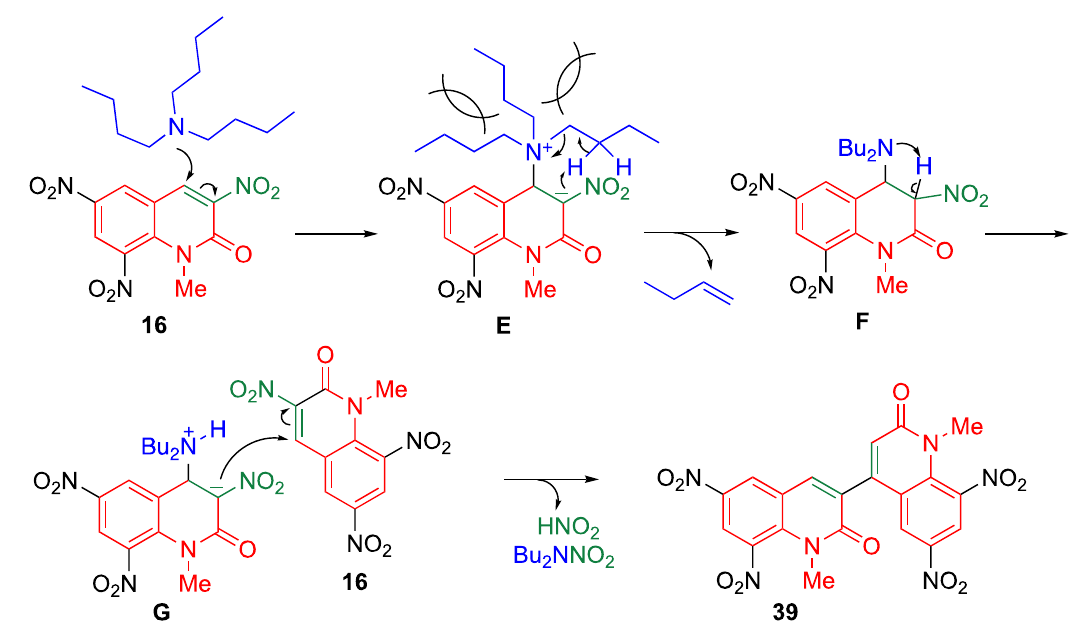
Table 12. Reactions of 16 with tertiary amines. R 1